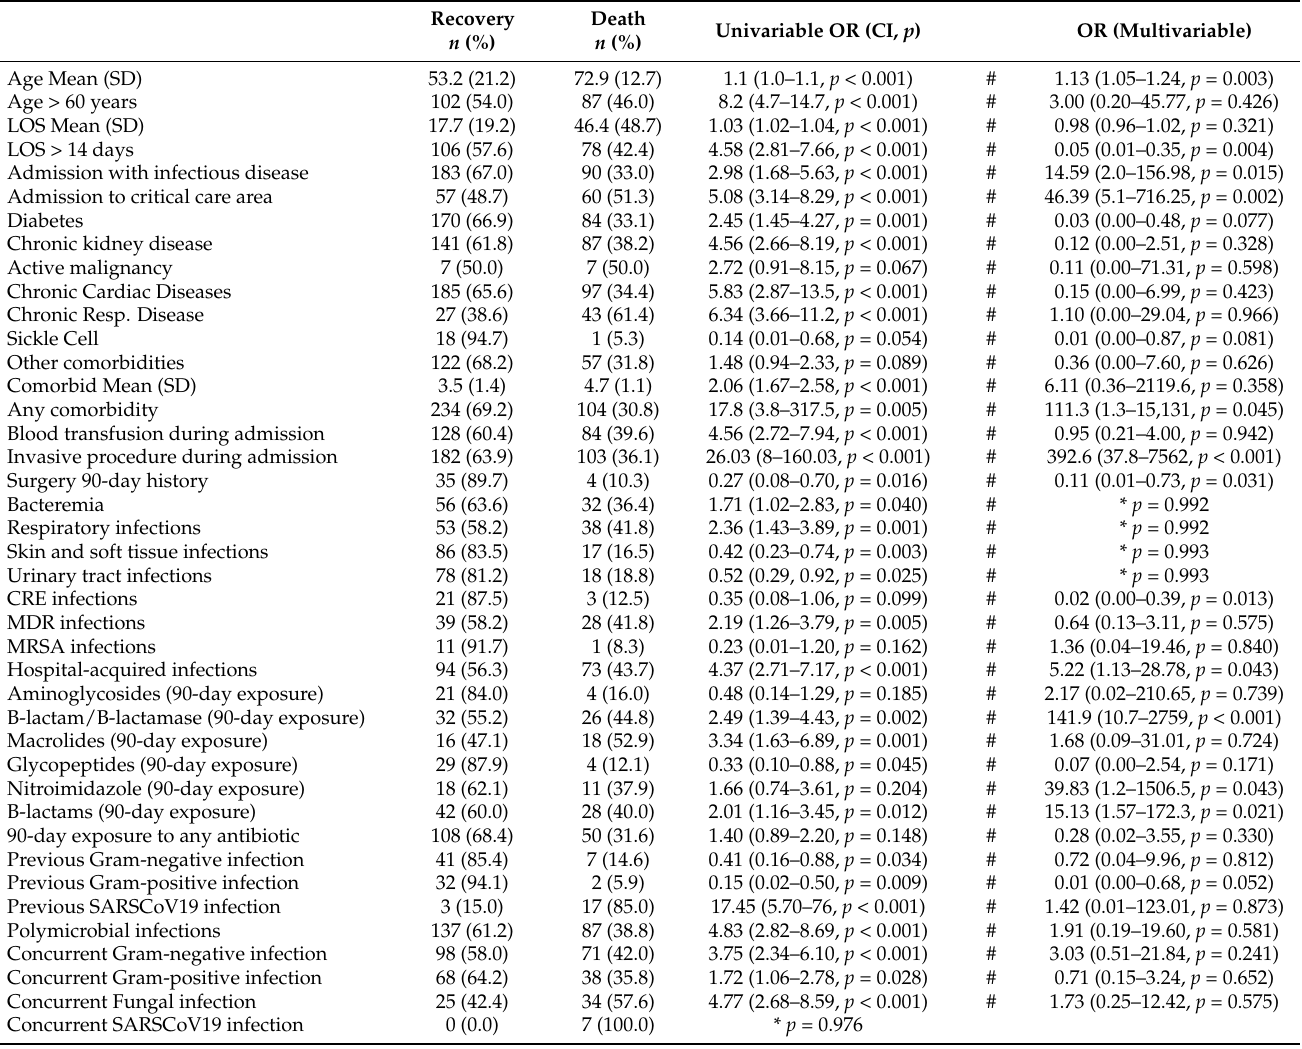
Table 2. Predictors for infection-related crude all-cause in-hospital